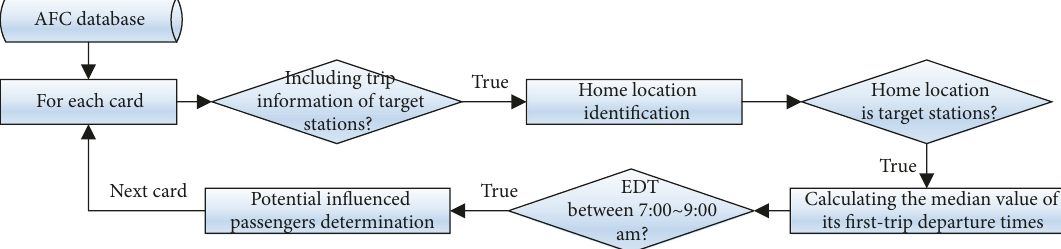
Figure 4: Process for extracting potentially influenced passengers due to the discount price.